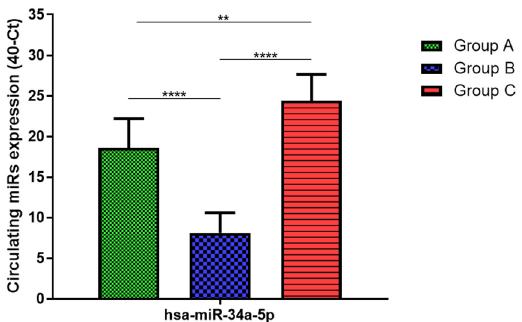
Figure 3. Serum levels of hsa-miR-34a-5p in HNW (Group A), MANW (Group B) and HNAO (Group C). Results were shown as means ± SD. The statistical tests used in these analyses were one-way analysis of variance using Kruskal–Wallis test followed by Dunn’s Multiple Comparison Test. ** p < 0.01, **** p < 0.0001.